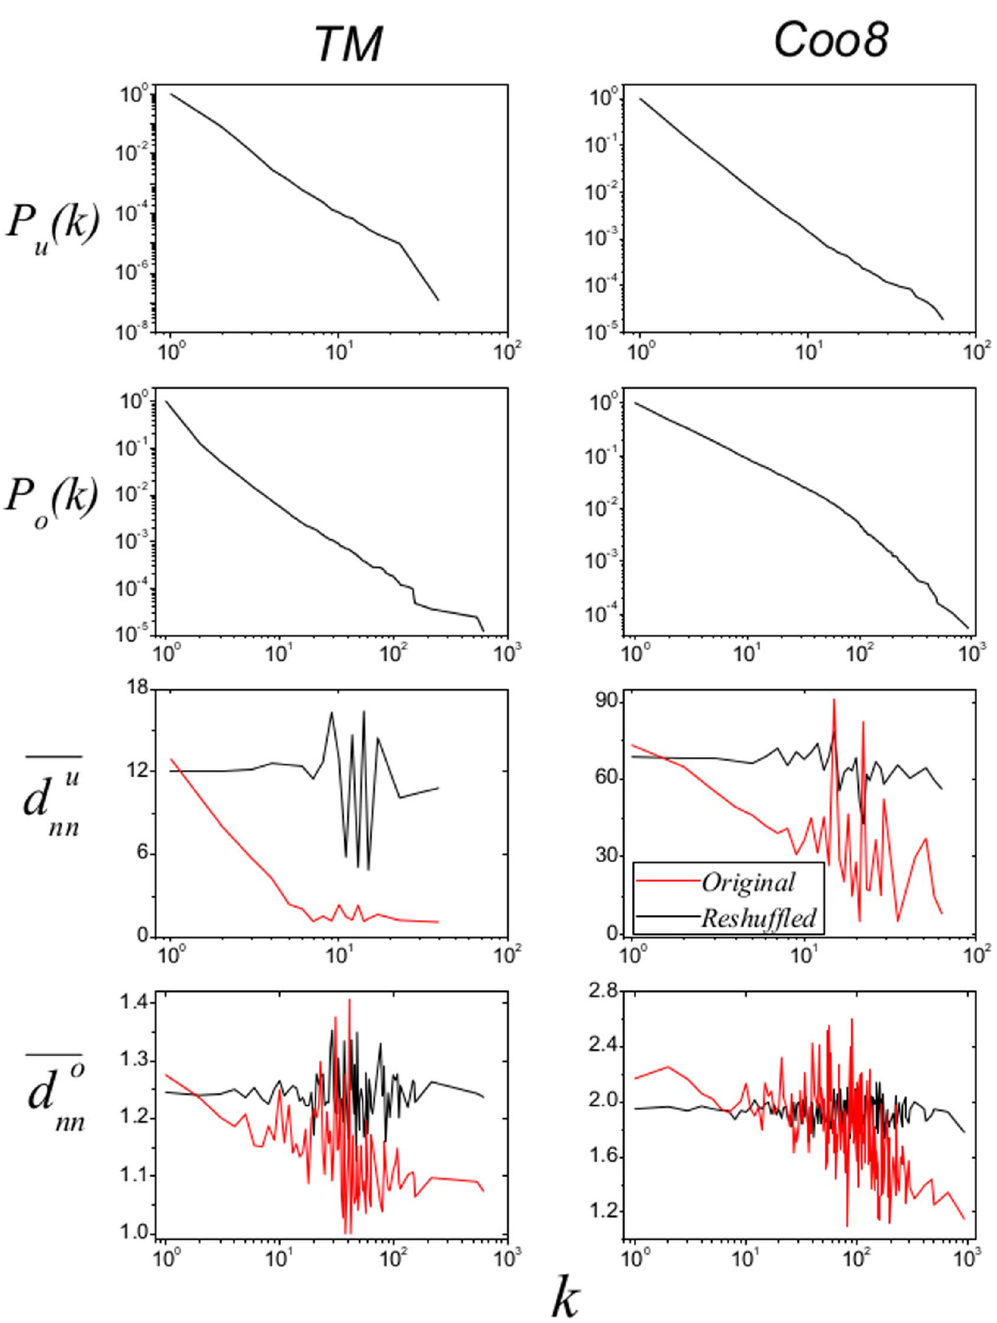
and d o are respectively showed in the 3rd and nn nn